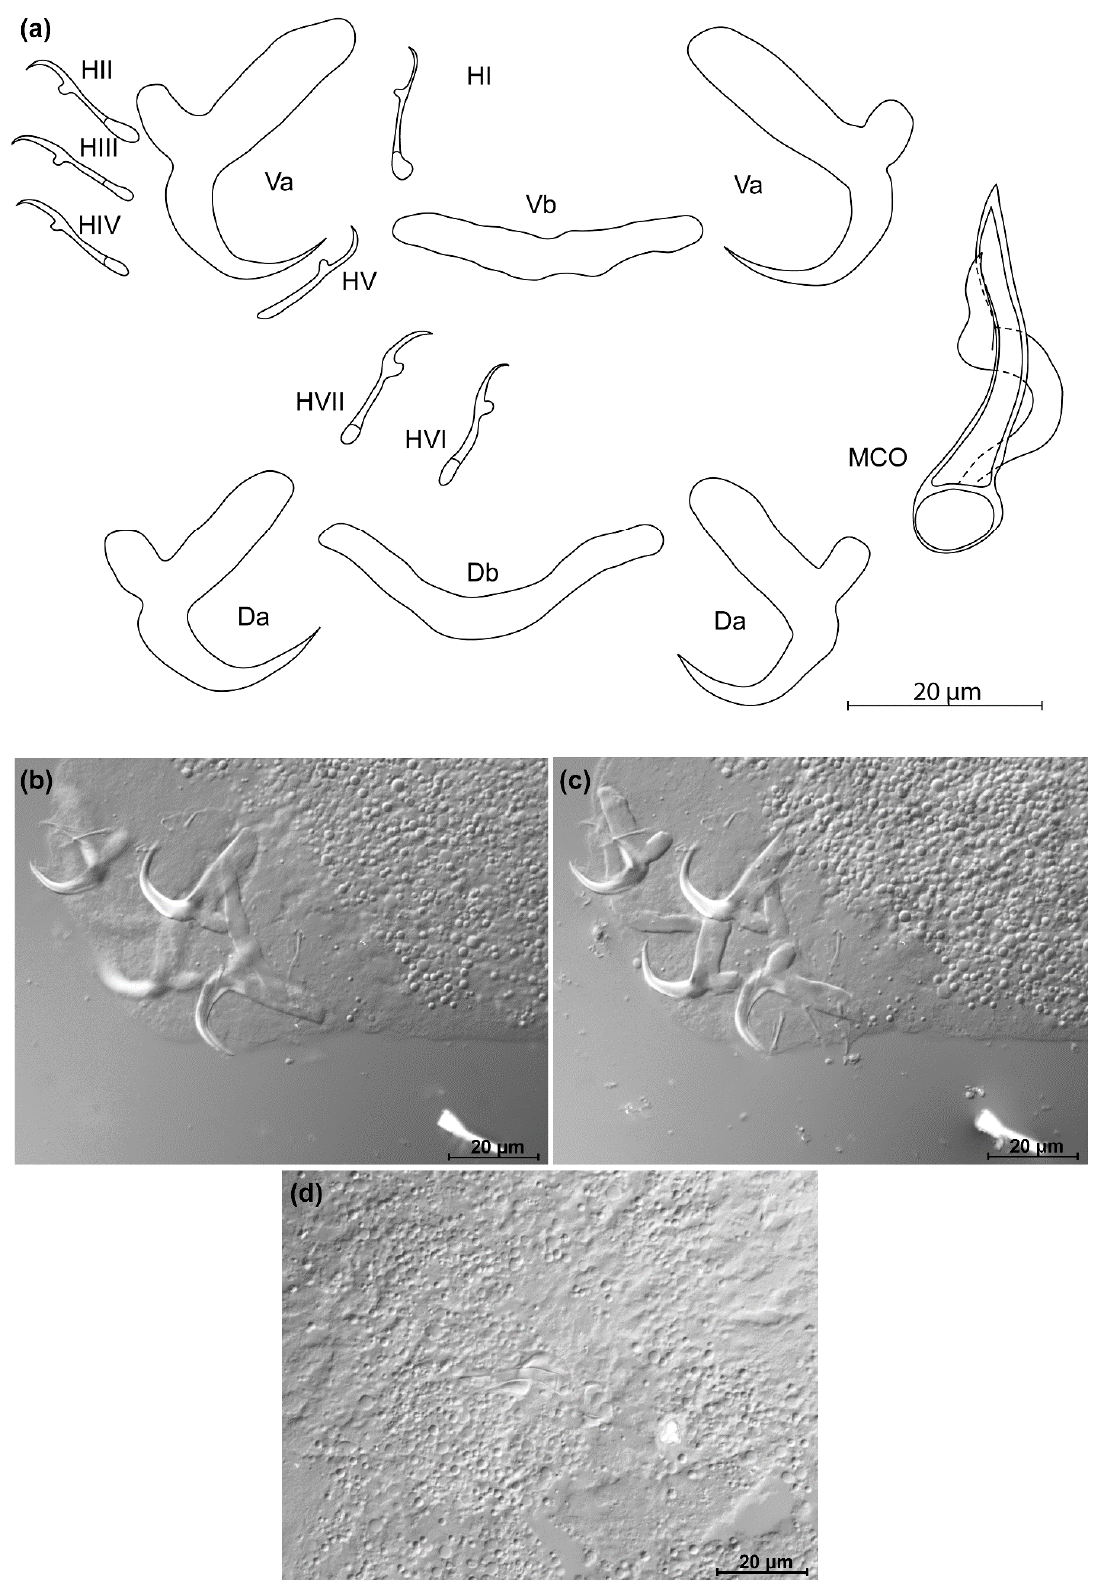
Figure 17. Kapentagyrus rochetteae n. sp. (ex Microthrissa royauxi ). ( a ) Drawings of sclerotized structures, Va-ventral anchors, Db-dorsal bar, Vb-ventral bar, H-hooks (pairs I to V—ventral; pairs VI, VII—dorsal). ( b ) Micrograph of ventral anchors and ventral bar. ( c ) Micrograph of dorsal anchors and dorsal bar. ( d ) Micrograph of MCO.